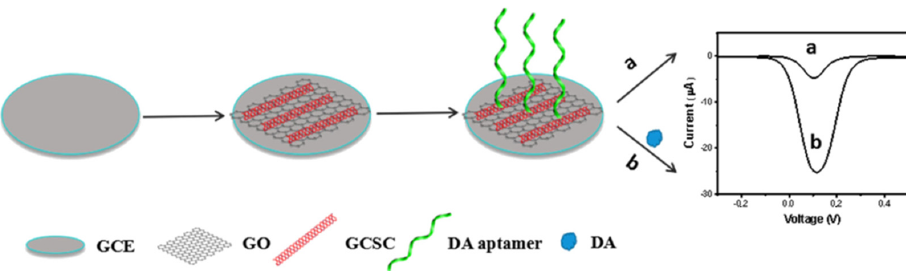
Figure 4. Modification of electrode surface with grass carp skin collagen (GCSC), graphene oxide (GO) nanocomposite, and construction of aptasensor for the detection of dopamine. Adapted with permission from Wei et al. [62]. Copyright © (2019), Elsevier.